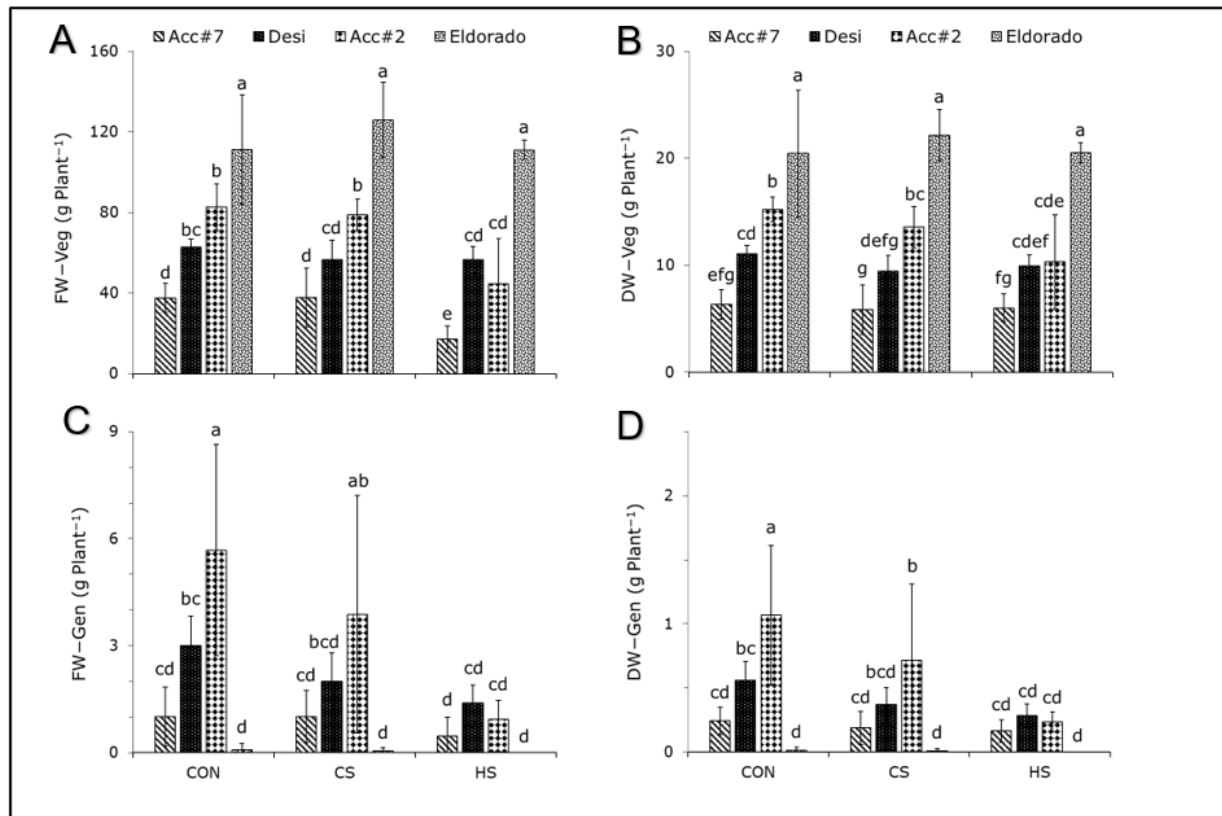
Figure 6. ( A ) Fresh weight vegetative (FW − Veg), ( B ) dry weight vegetative (DW − Veg), ( C ) fresh weight generative (FW − Gen) and ( D ) dry weight generative (DW − Gen) of four chickpea genotypes under the treatments for 3 days. “CON”, 25/20 ◦ C day/night; “CS”, 8/4 ◦ C day/night; “HS”, 38/33 ◦ C day/night. The data represent average values ± SD ( n = 4). Different small letters above the bars indicate significant differences ( p <